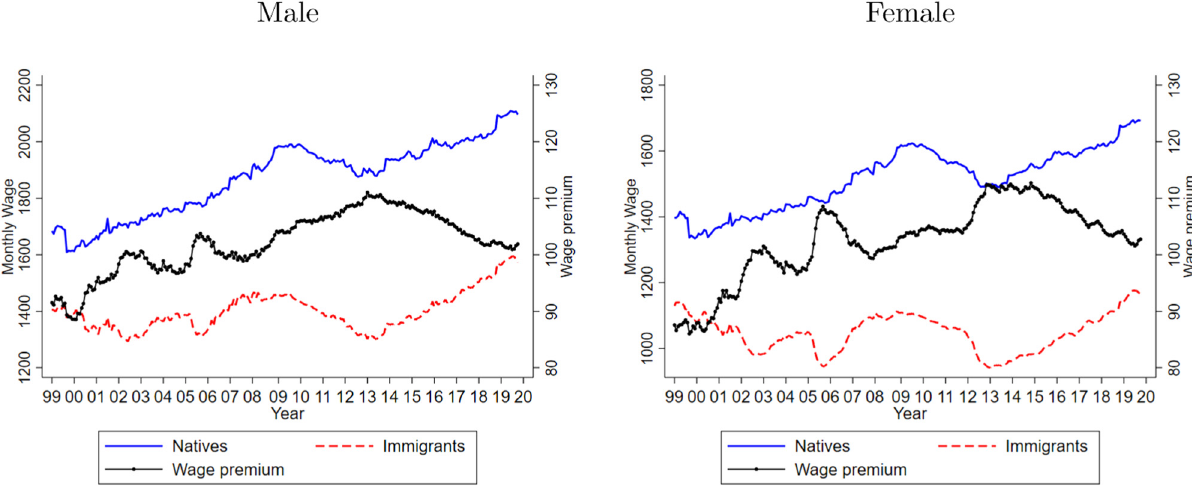
Figure A13: Monthly average wage by nationality and gender. Note: The wage premium is computed as ( ) ∕ w w ¯ ¯ − 1 N t M t , , , where w ¯ j t , is the monthly average wage for natives = j N and immigrants = j M at month t . Wage premium is normalised to 100 at 2008Q1. Wages are seasonally adjusted by taking out the coe ffi cient of the monthly dummies from an OLS regression. Source: